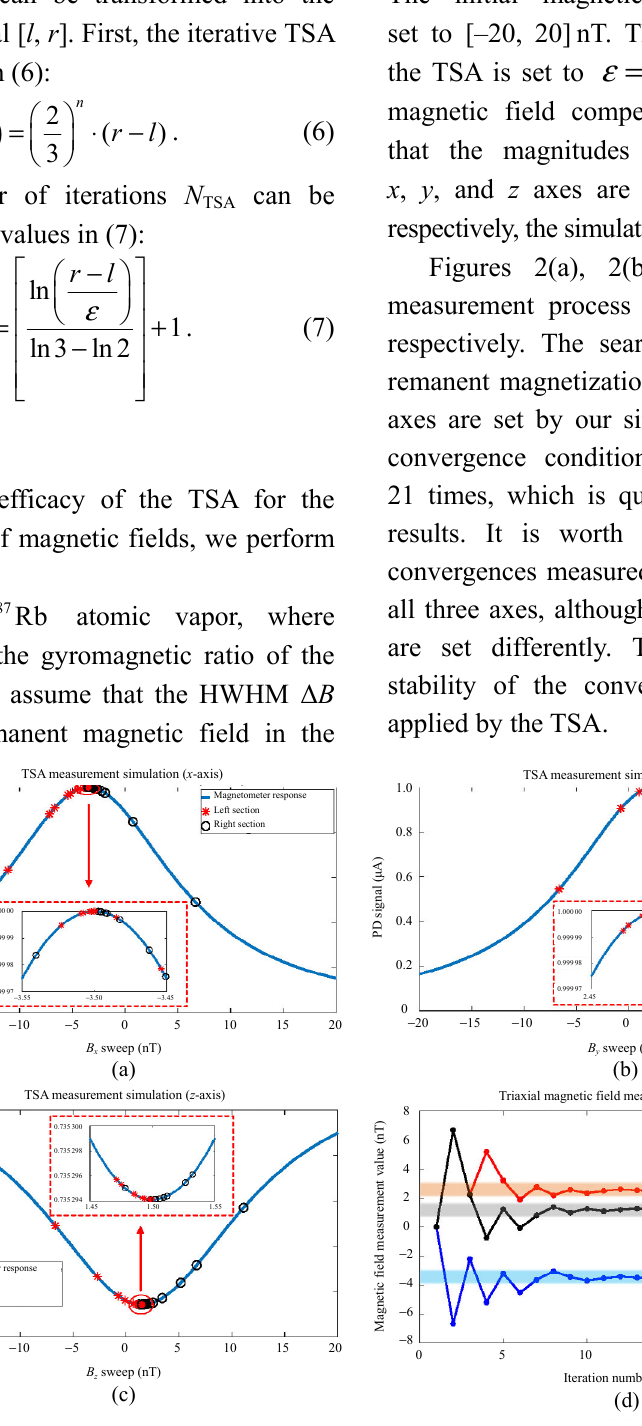
Fig. 2 Simulation of a three-axis magnetic field measurement process: (a), (b), and (c) correspond to the fast magnetic field convergence process in the x - (–3.5 nT), y - (2.5 nT), and z - (1.5 nT) axes under the TSA algorithm; (d) demonstrates the triaxial magnetic field measurement process. The number of iterations for all three axes is 21, indicating that the algorithm is more stable between different remanent magnetic